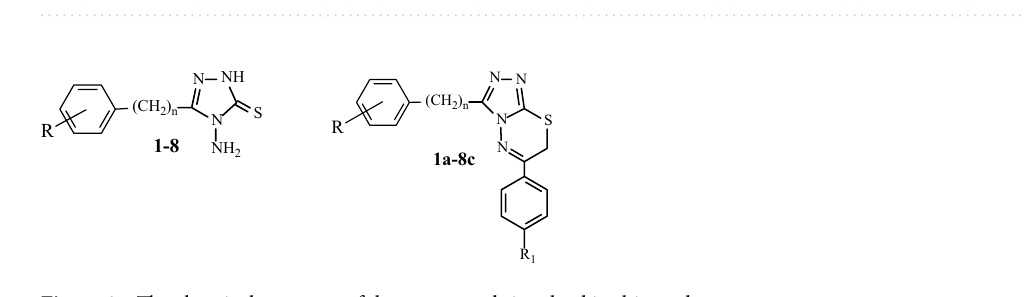
Figure 2. The chemical structure of the compounds involved in this